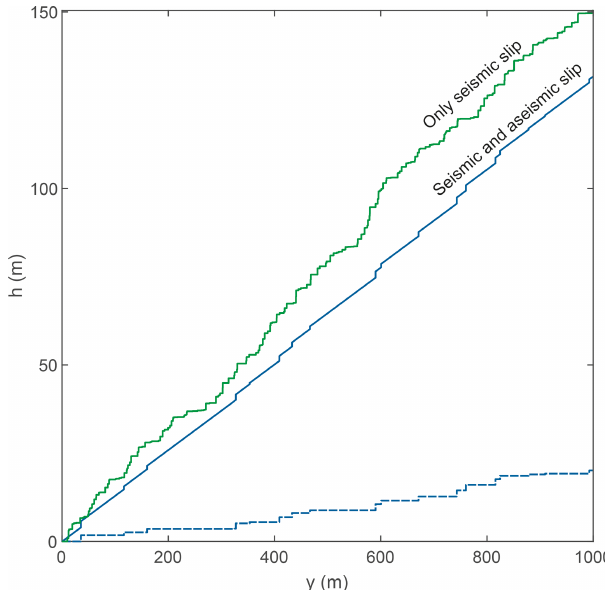
Figure 6. Modelled river profiles considering the “only seismic slip” (green line) and the “seismic and aseismic slip” (blue line) models. For the latter, the contribution of seismic slip is shown (dashed blue